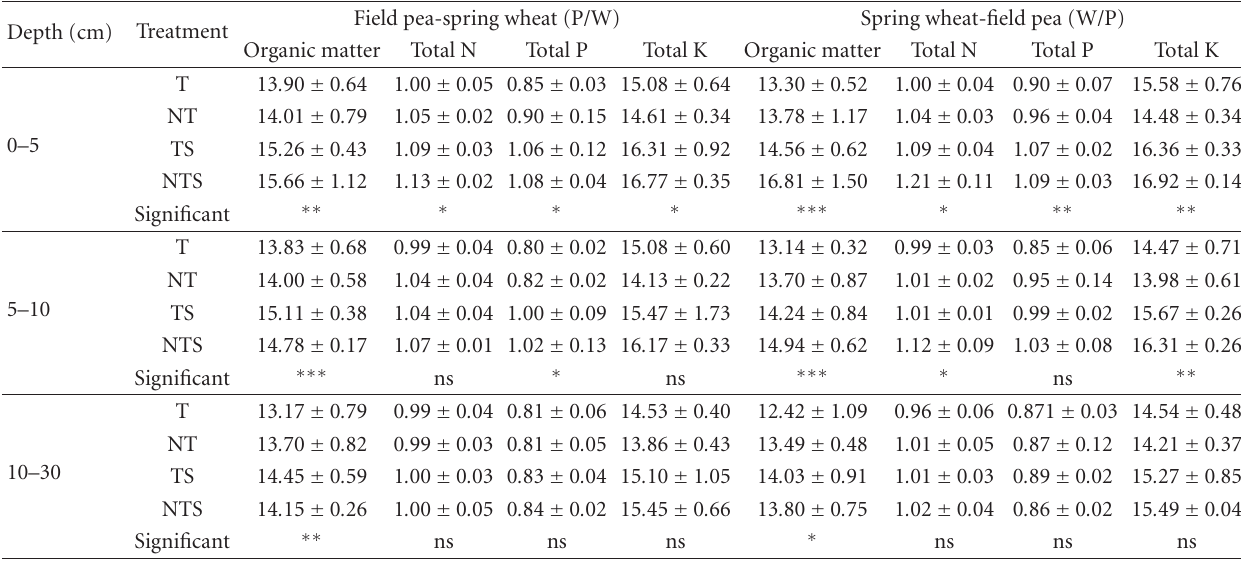
Table 3: Soil total nutrients as a ff ected by stubble management in di ff erent rotation sequence (gkg − 1 ). Depth (cm)